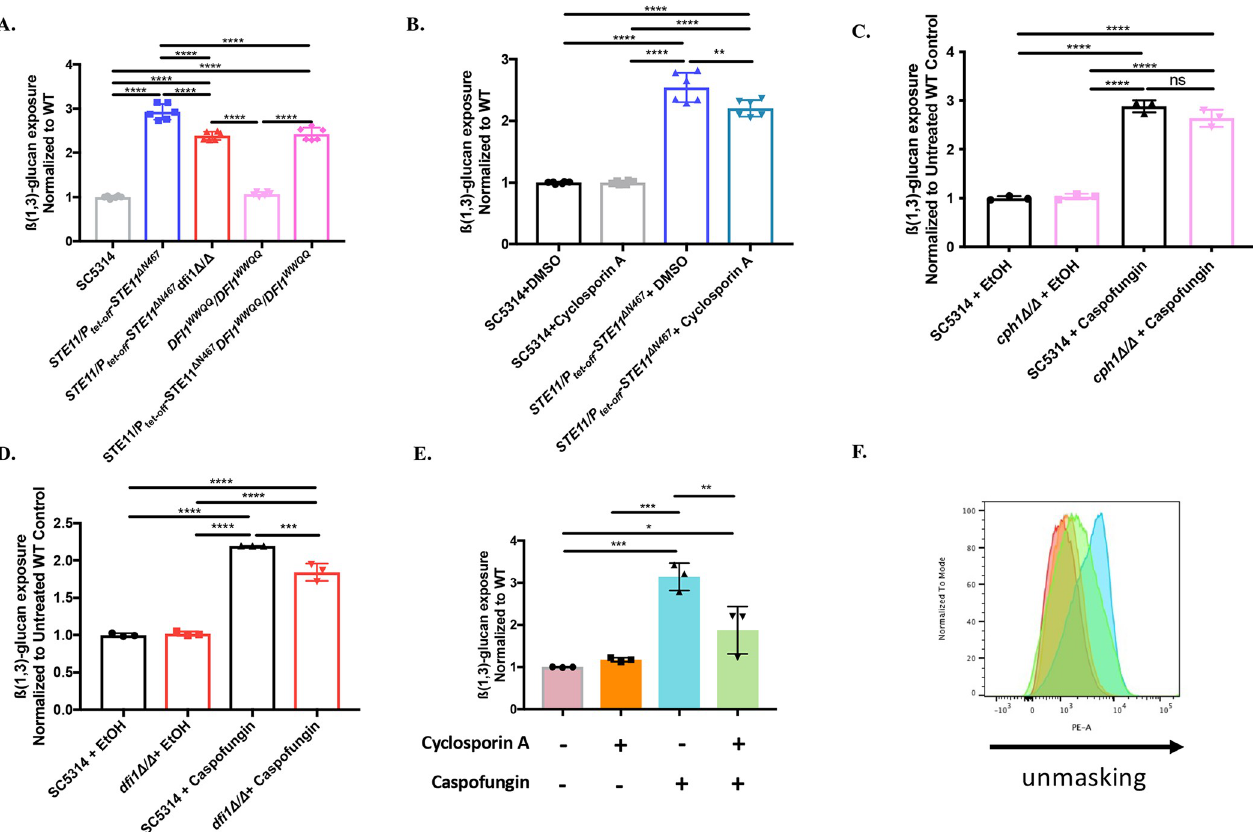
Fig 1. Calcineurin mediates hyperactive Ste11 Δ N467 -induced and caspofungin-induced unmasking in C . albicans . (A) Disruption of the Dfi1-calmodulin interaction reduces Ste11 Δ N467 -induced unmasking. Cells from overnight cultures were stained with an anti-ß(1,3)-glucan antibody and a phycoerythrin- conjugated secondary antibody, and flow cytometry analysis was used to assess the levels of ß(1,3)-glucan exposure. (n = 3 biological replicates with 1 technical replicate for each)( ���� p < 0.0001, by one-way ANOVA). (B) Cyclosporine A inhibition of calcineurin reduces Ste11 Δ N467 -induced unmasking. The SC5314 Δ N467 mutant was grown overnight in either the presence of 100 μ g/ml of cyclosporine A or an appropriate volume of the wild-type or the STE11/P tet-off -STE11 DMSO solvent control, and ß(1,3)-glucan exposure was assessed via flow cytometry. (n = 3 biological replicates with 1 technical replicate for each)( �� p < 0.005, ���� p < 0.0001, by one-way ANOVA). (C-D) Genes that are necessary for Ste11 Δ N467 -induced unmasking were tested for their roles in caspofungin-induced unmasking by treating cells grown to mid-log phase with 46.9ng/ml of caspofungin for 30 minutes followed by flow cytometry. (C) ß(1,3)-glucan unmasking in cph1 Δ / Δ cells treated with sublethal concentrations of caspofungin. (n = 3 biological replicates)( ���� p < 0.0001, by one-way ANOVA). (D) ß(1,3)-glucan unmasking in dfi1 Δ / Δ cells treated with sublethal concentrations of caspofungin. (n = 3 biological replicates)( ��� p = 0.0005, ���� p < 0.0001, by one-way ANOVA). (E) Calcineurin inhibition attenuates caspofungin-induced unmasking. SC5314 wild-type cells grown to mid-log phase in either the presence of 100 μ g/ml of cyclosporine A, or an appropriate volume of the DMSO solvent control, were exposed to 46.9ng/ml of caspofungin or ethanol control for 30 minutes, and ß(1,3)-glucan exposure was measured via flow cytometry. (n = 3 biological replicates)( � p < 0.05, �� p < 0.01, ��� p < 0.0005, by one-way ANOVA). (F) Representative histogram of the impact that cyclosporine A-mediated calcinuerin inhibition has on caspofungin induced ß(1,3)-glucan exposure. Colors of each sample match those shown in